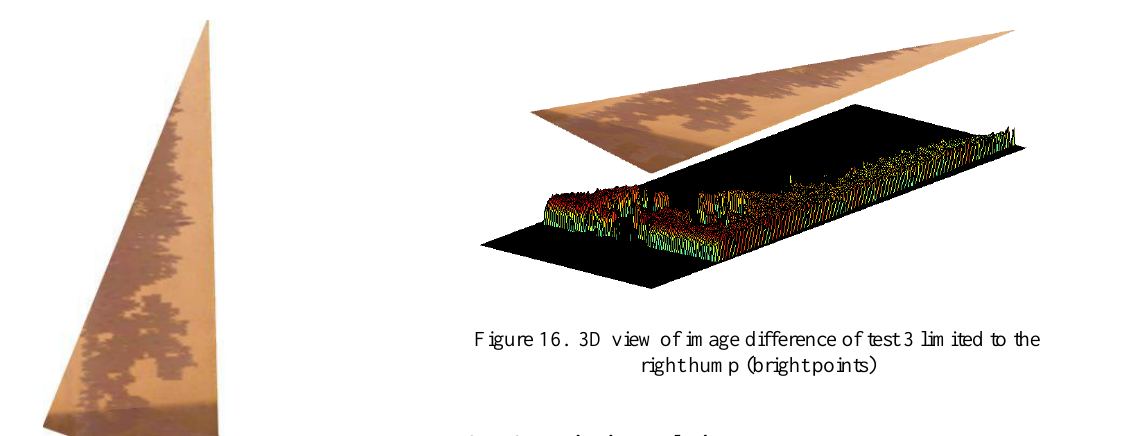
Figure 15. 3D view of image difference of test 3, limited to the left hump (dark points)